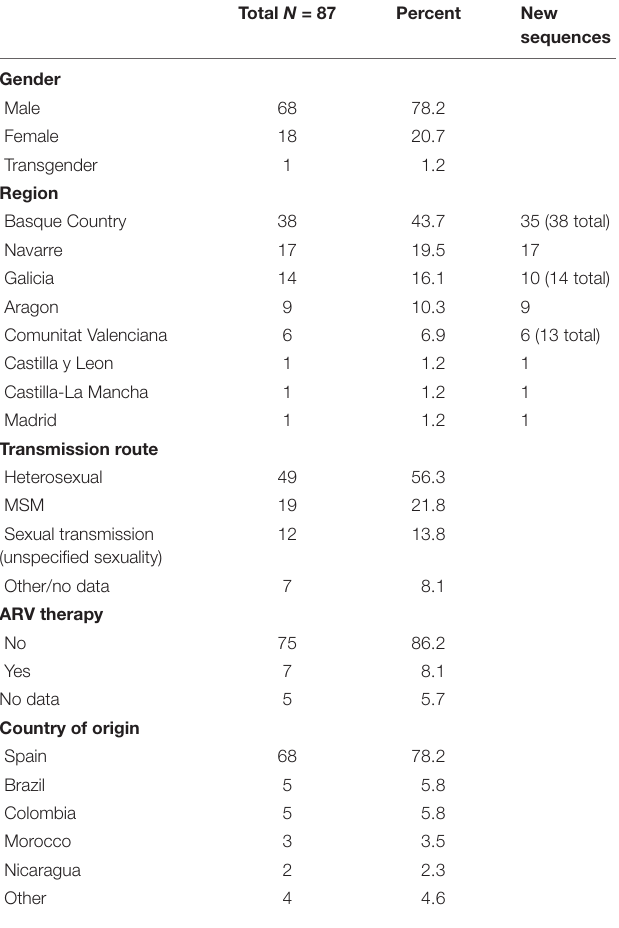
TABLE 1 | Summary data from patients with CRF47_BF variant from